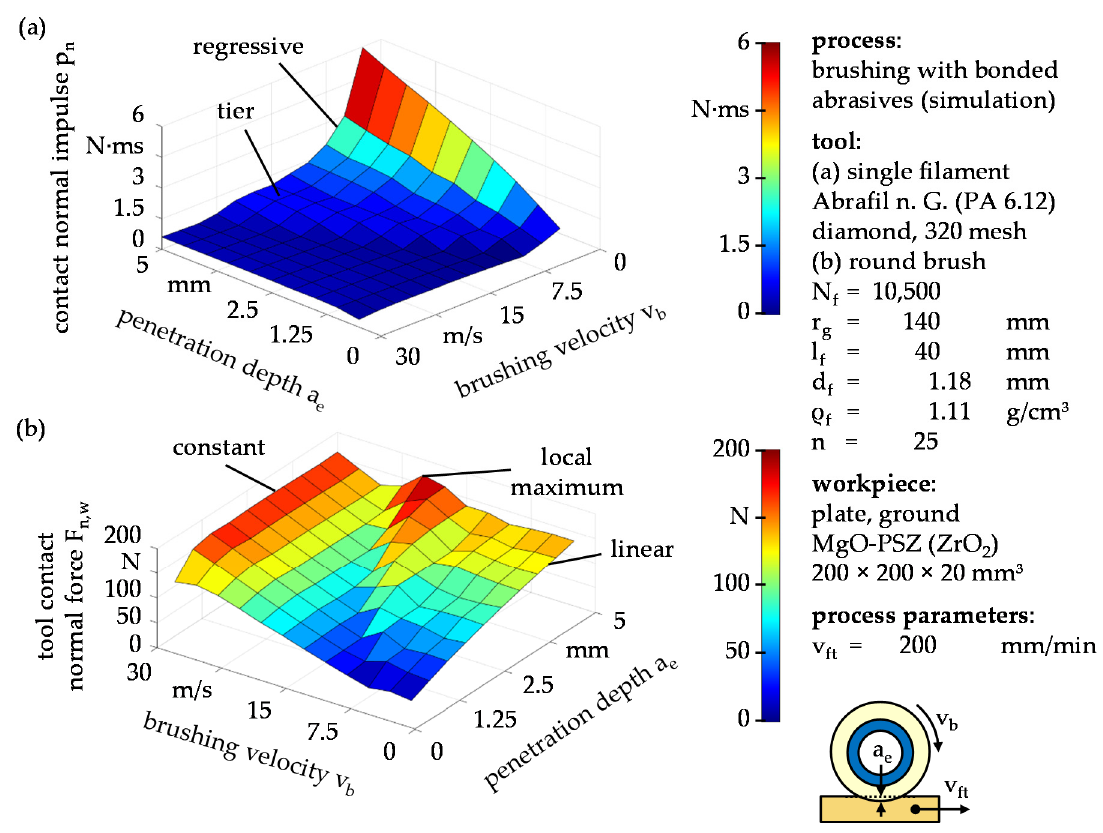
Figure 6. Extrapolation of filament–workpiece contact forces; ( a ) contact normal impulse p n and ( b ) tool contact normal force F n,w for different brushing velocities v b and penetration depths a e .